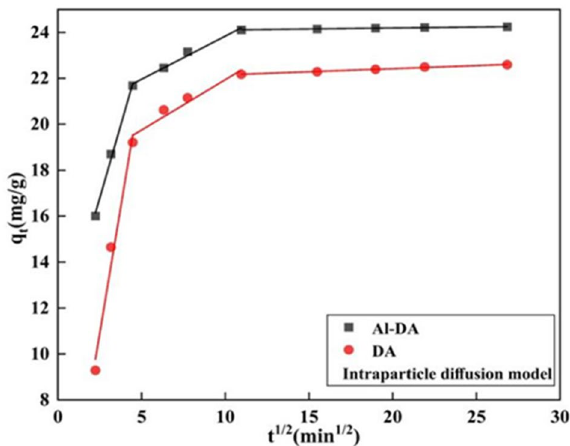
Figure 8. Fit the experimental data using the internal diffusion equation (fluoride initial concentration is 100 mg/L, Sorbent dose 4 g/L, pH 6, contact time is 2 h).